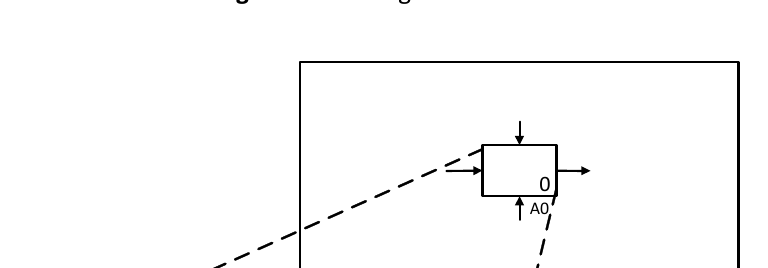
Figure 1. Building blocks in the IDEF0 model